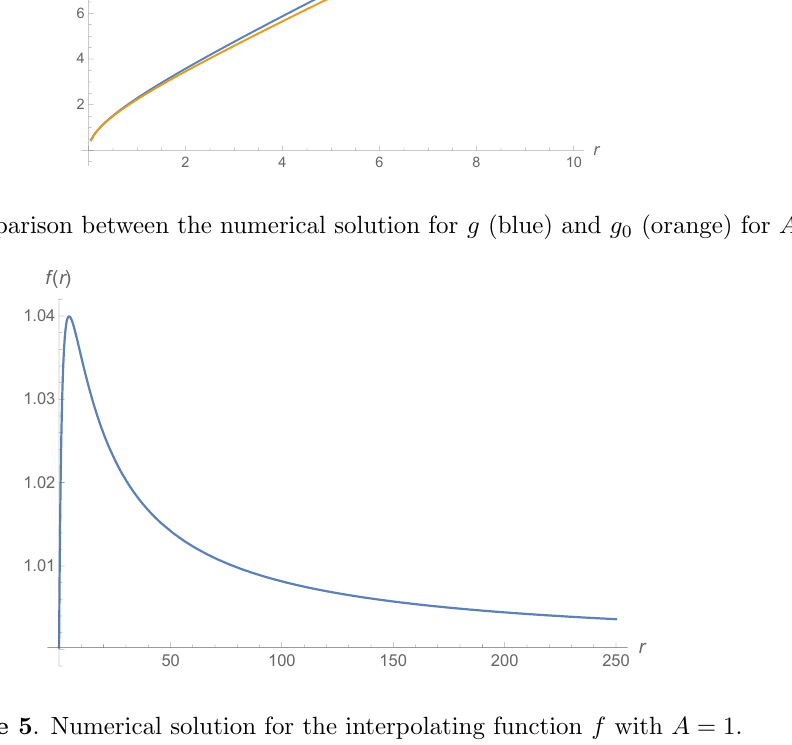
Figure 5 . Numerical solution for the interpolating function f with A =